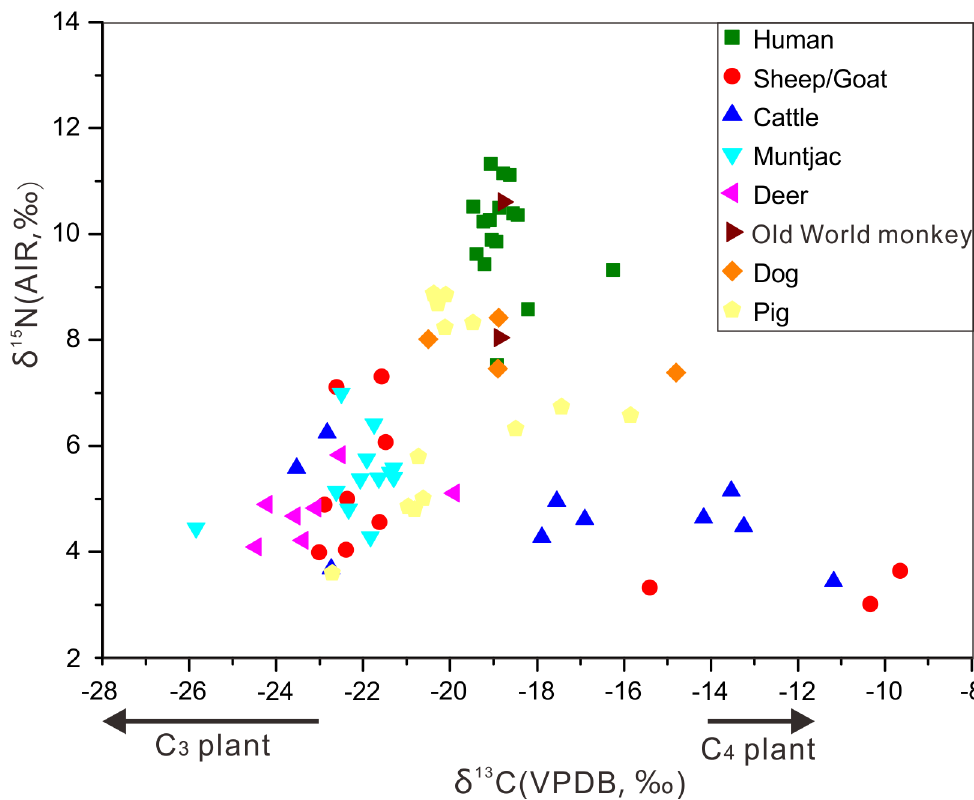
Fig 3. Scatter diagram of human and animal collagen carbon and nitrogen values from Shilinggang. Analytical error is so small that it is containedwithin the symbols.